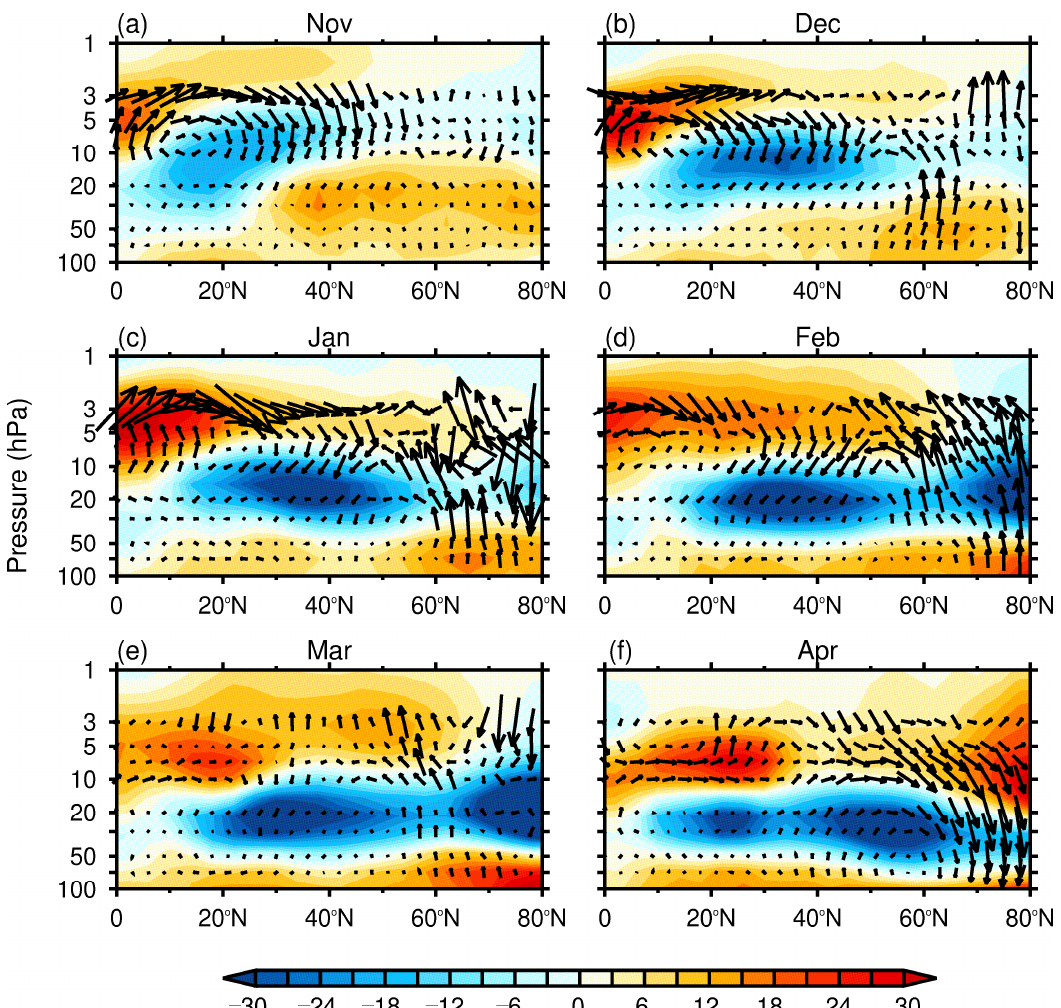
Figure 5. Month-to-month evolution of anomalies of the residual circulation ( v ∗ , w ∗ , arrows) and N 2 O (contours) ( a – f ) from November 2010 to April 2011. The vertical component of the residual circulation was multiplied by 500. N 2 O values are based on MLS data.